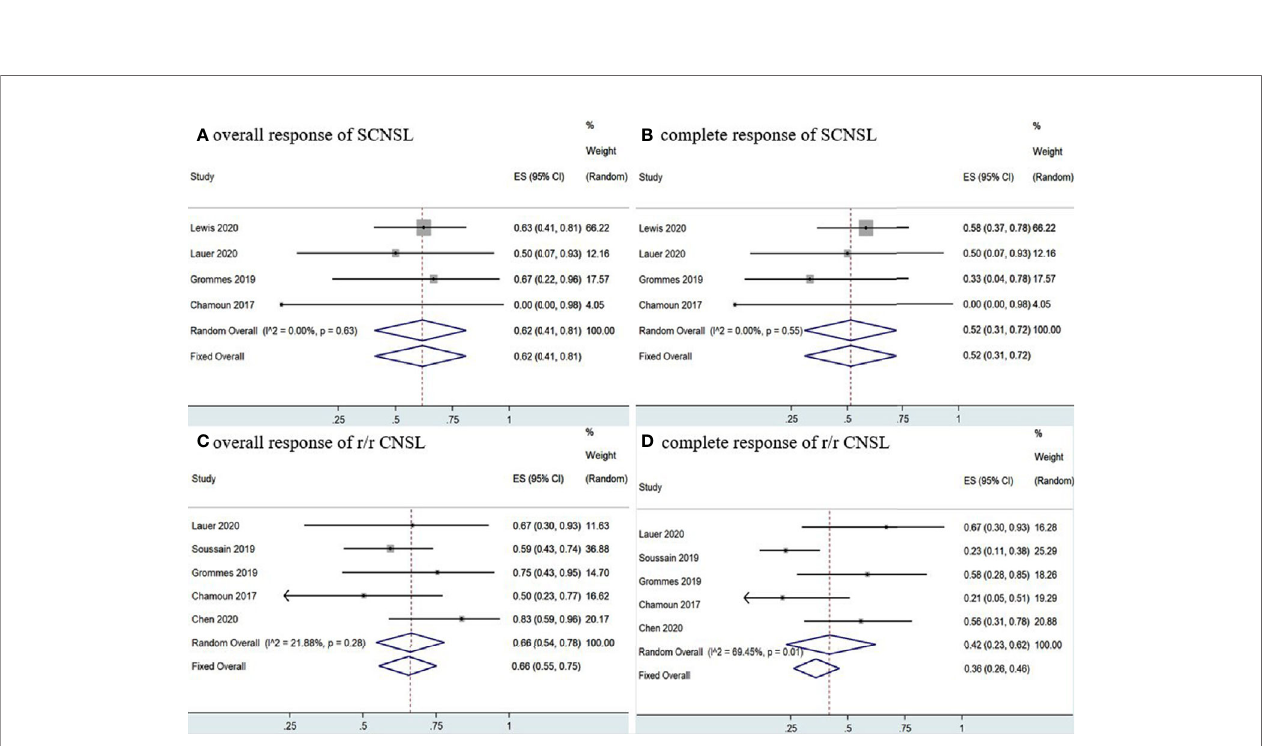
FIGURE 6 | Pooled response rates of secondary central nervous system lymphoma (SCNSL) and refractory/relapsed central nervous system lymphoma (r/r CNSL). (A) Pooled overall response of SCNSL. (B) Pooled complete response of SCNSL. (C) Pooled overall response of r/r CNSL. (D) Pooled complete response of r/r CNSL.